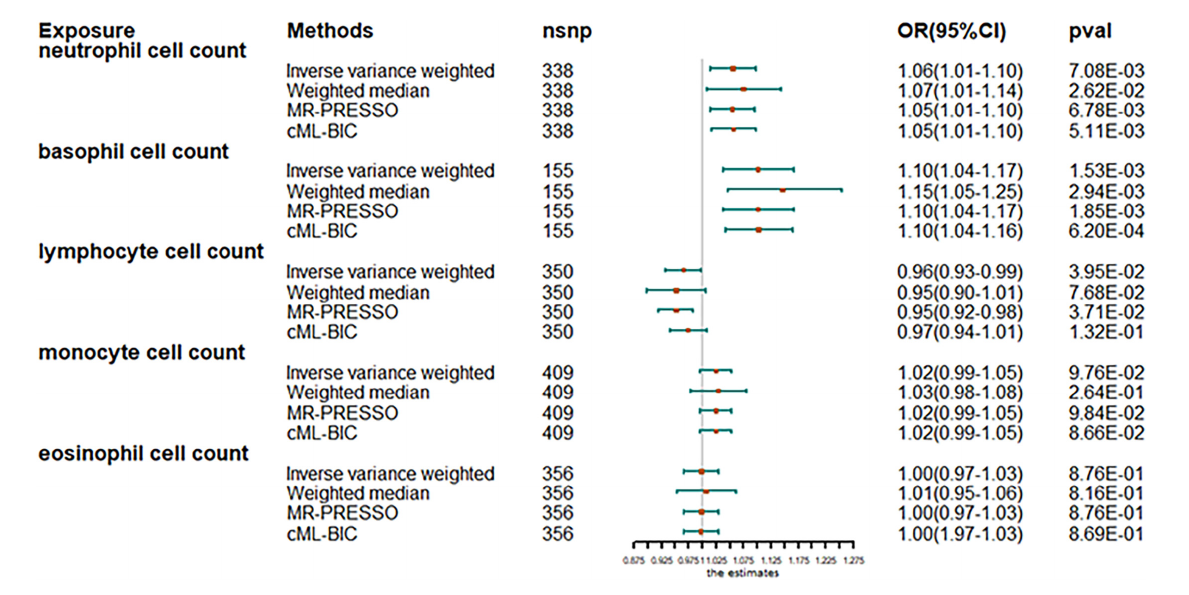
FIGURE1 Mendelian randomization estimates of the association between blood cell counts and risk of atrial fibrillation. OR, odds ratio; CI, confidence interval.